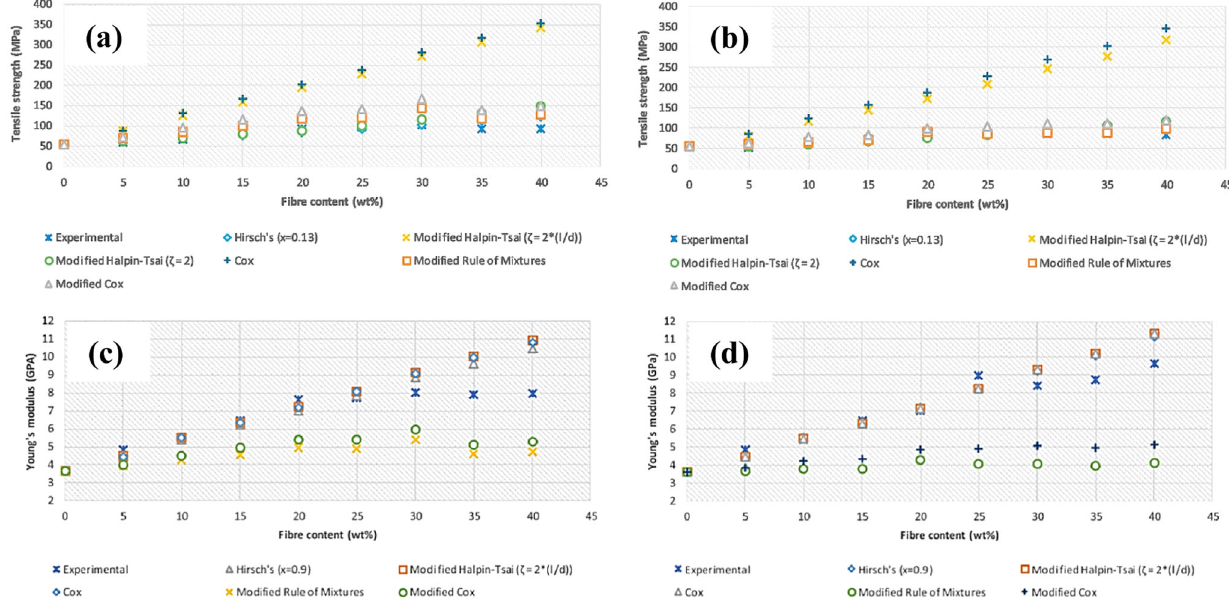
Fig. 17 Mechanical properties of PLA/natural fi ber biocomposites. Variation of actual and predicted a tensile strength of PLA/harakeke Biocomposites, b tensile strength of PLA/hemp fi ber biocomposites, c Young ’ s moduli of PLA/harakeke biocomposites, and d Young ’ s moduli of PLA/hemp fi ber 159